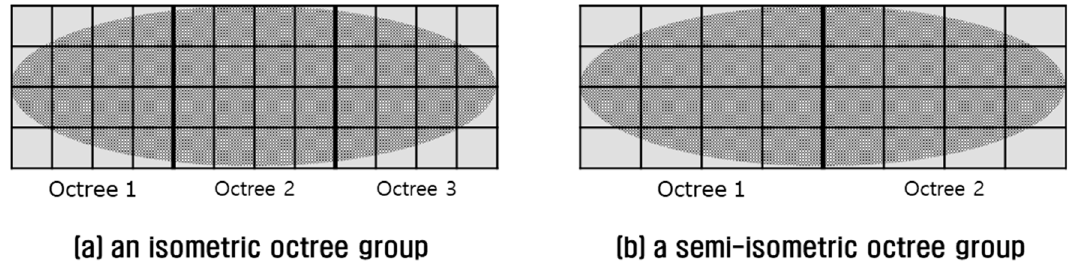
Figure 8. Comparison of octree groups: ( a ) an isometric octree group; ( b ) a semi-isometric octree group.